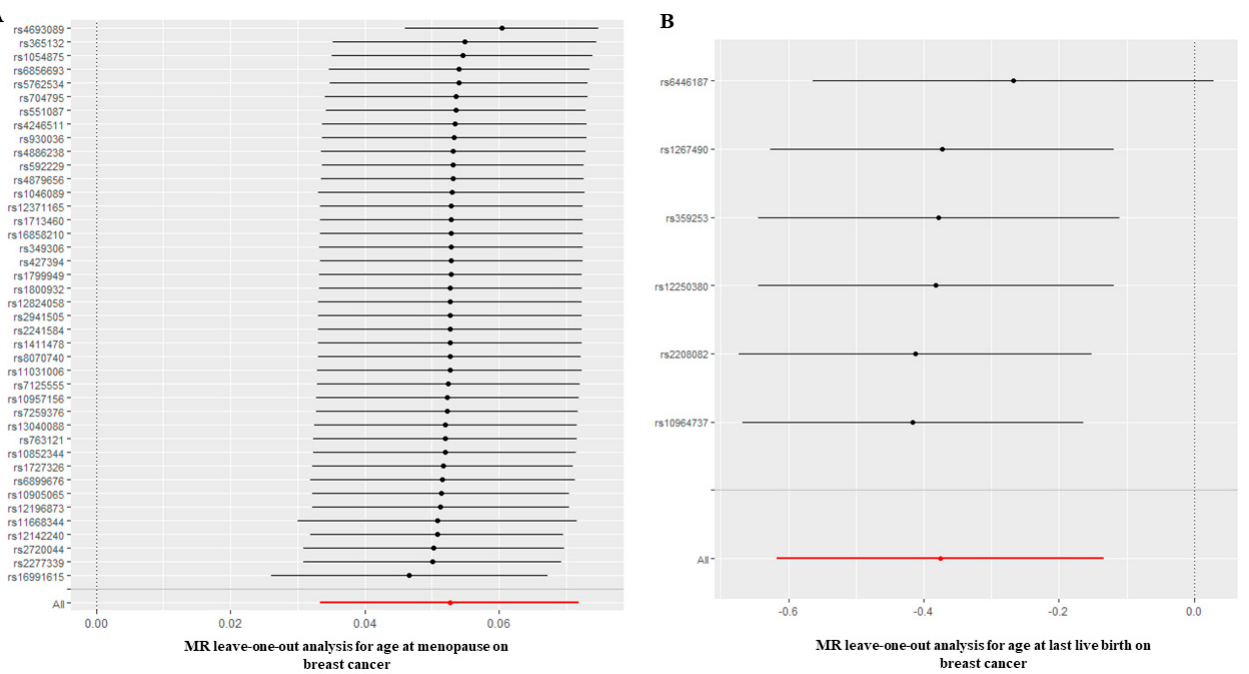
Figure 3. ( A ) Leave-one-out analysis plots for age at menopause on BC. ( B ) Leave-one-out analysis plots for age at last live birth on BC. BC: breast cancer.